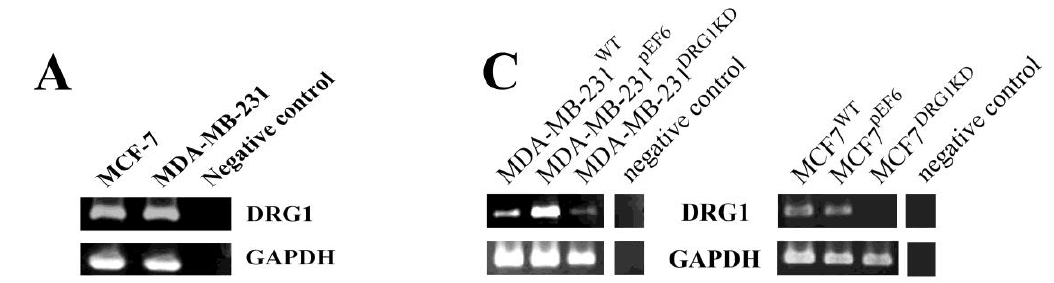
Figure 2. Confirmation of knockdown of DRG1 in MCF7 and MDA-MB-231 human breast cancer cell lines. ( A ) DRG1 expression was observed in both MCF7 and MDA-MB-231 breast cancer cell lines; ( B ) Secondary structure of human DRG1 which was used in the design of anti-DRG1 transgenes; ( C ) Low transcript levels of DRG1 were seen in MCF7 DRG1KD and MDA-MB-231 DRG1KD cells using RT-PCR; ( D ) Knock down of